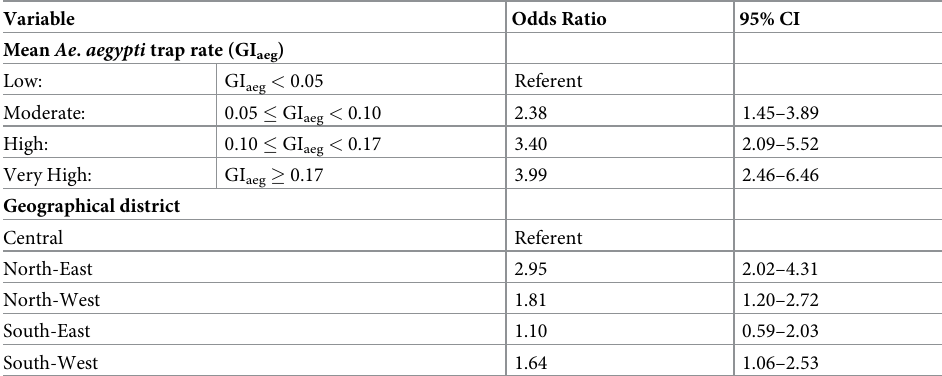
Table 3. Adjusted odds ratios for factors associated with dengue cluster